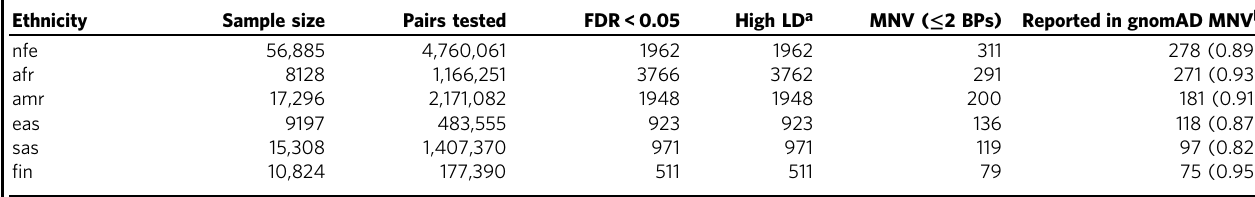
Table 1 LD detection of annotated functional variants within each gene by using gnomAD summary